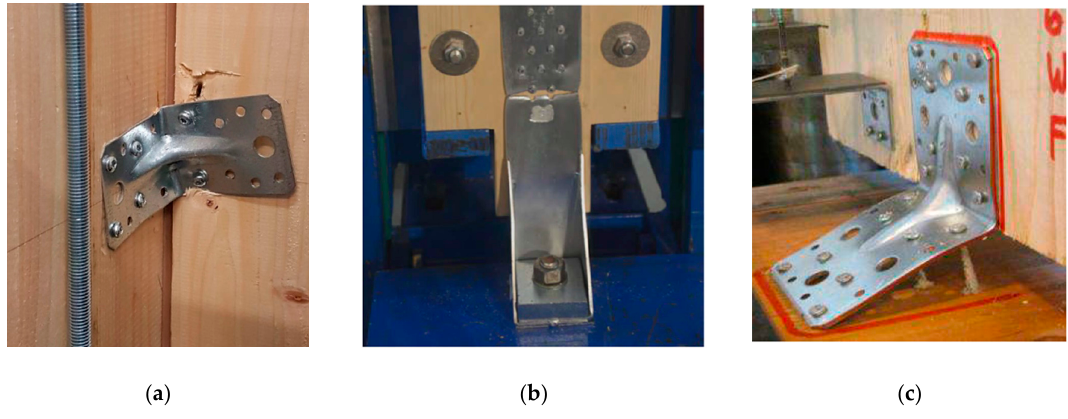
Figure 6. Different kinds of failure modes in timber plate connections: ( a ) cutting-through of fasten- ers in timber; ( b ) breakage in a metal connector; ( c ) pulling-out of fasteners [34,52]. in timber; ( b ) breakage in a metal connector; ( c ) pulling-out of fasteners